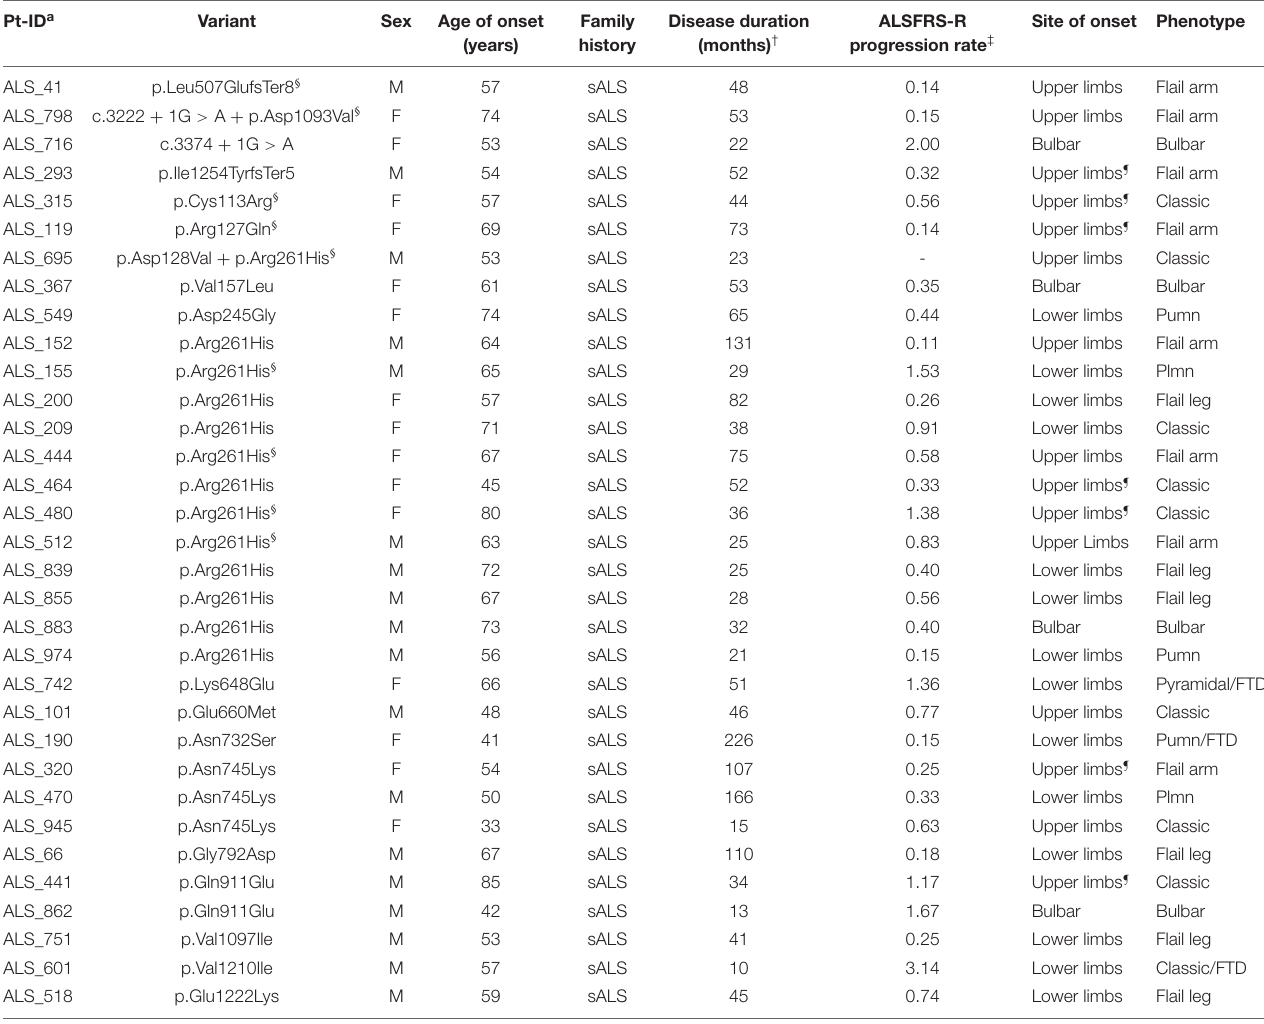
TABLE 2 | Demographic and clinical characteristics of patients with NEK1 variants.